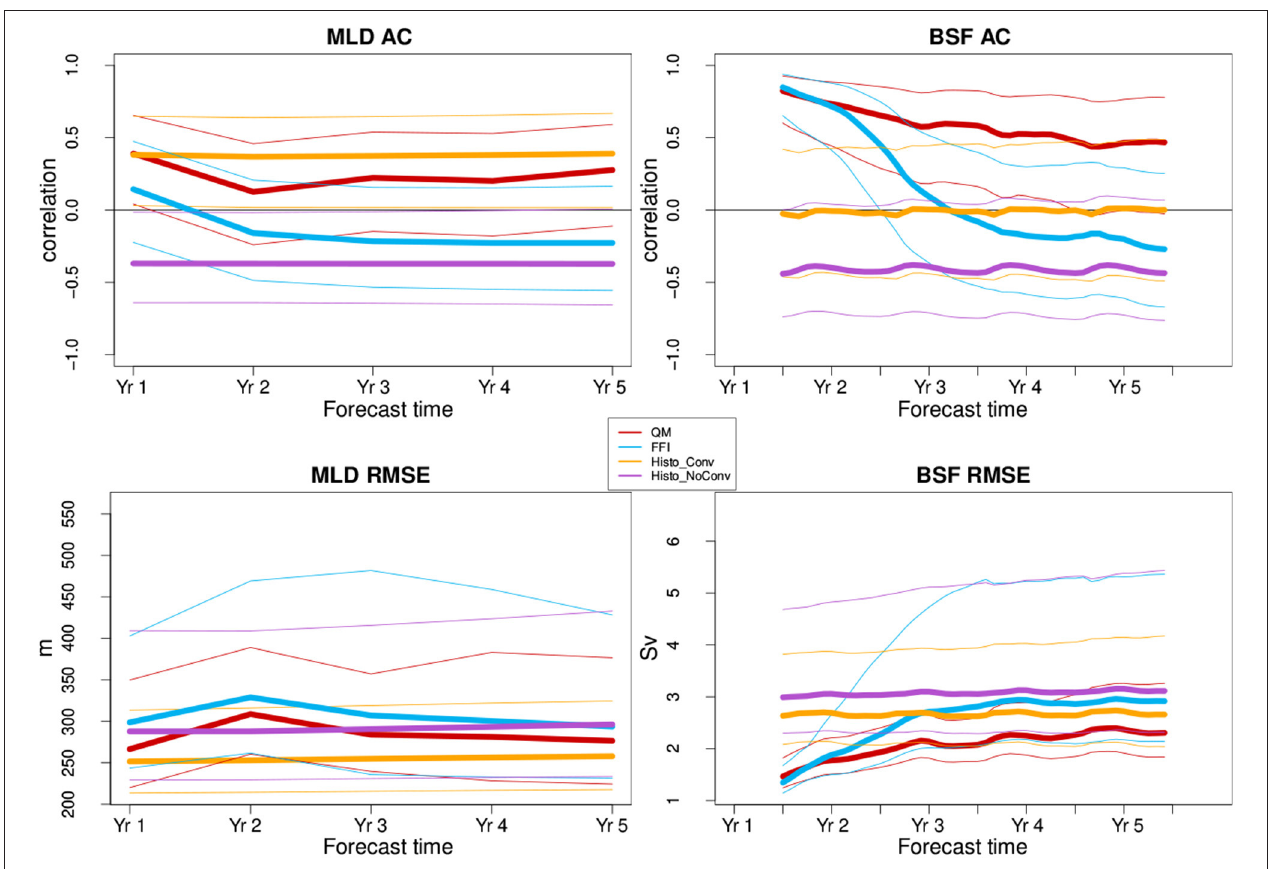
FIGURE 8 | Anomaly correlation of the mixed layer depth ( top left panel) and the barotropic stream function ( top right panel) in the Labrador Sea (55–65 ◦ N, 56–46 ◦ W). The second row shows the respective root mean square error (RMSE). Quantile matching (QM) is shown in red, the full-field initialization (FFI) in blue, the Histo with convection is shown in yellow, and in purple the Histo members with no convection. The skill are computed against NEMOVAR-ORAS4, using the February–March–April mean for the mixed layer depth, and a running mean of 12 months for the barotropic stream function. The thin lines represent the 95% confidence interval obtained with a t-distribution for the correlation and a χ 2 distribution for the